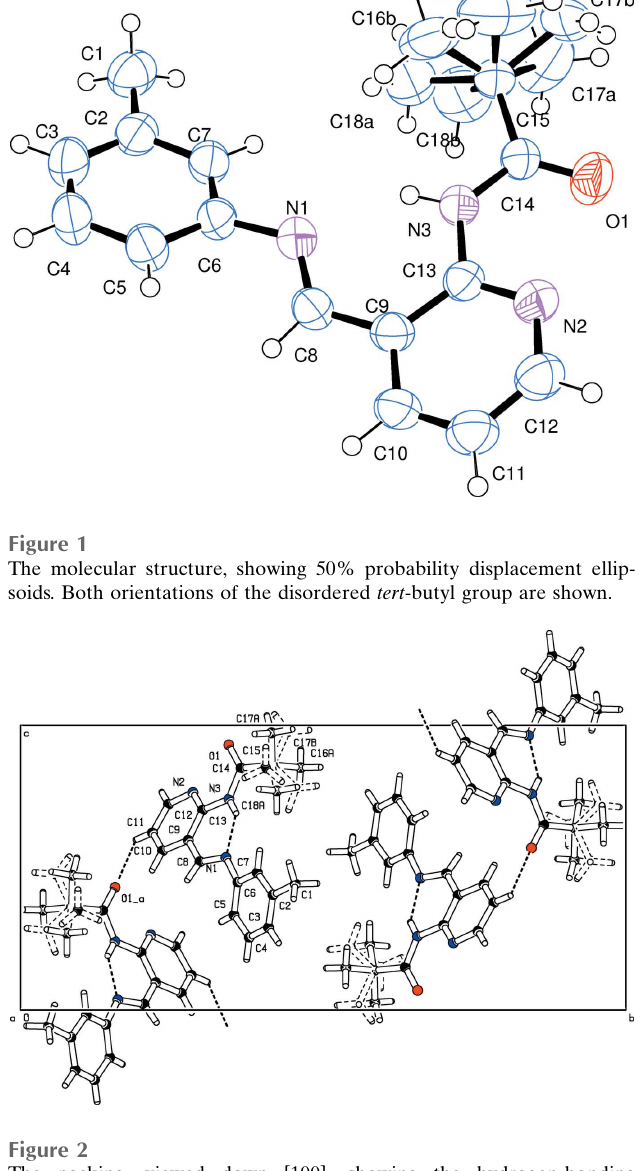
Table 1 Hydrogen-bond geometry (A˚ , (cid:2) ).